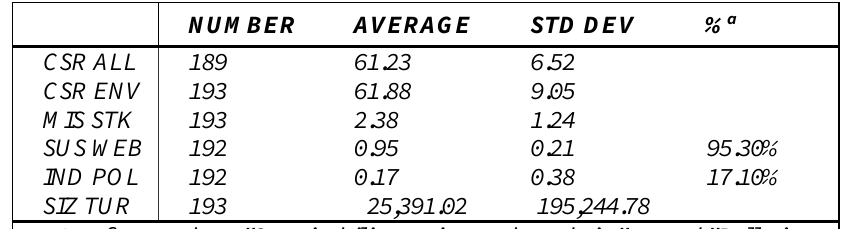
Table 2: Descriptive Statistics and Pearson’s Correlation Matrix NUMBER AVERAGE STD DEV % a CSR ALL 189 61.23 6.52 CSR ENV 193